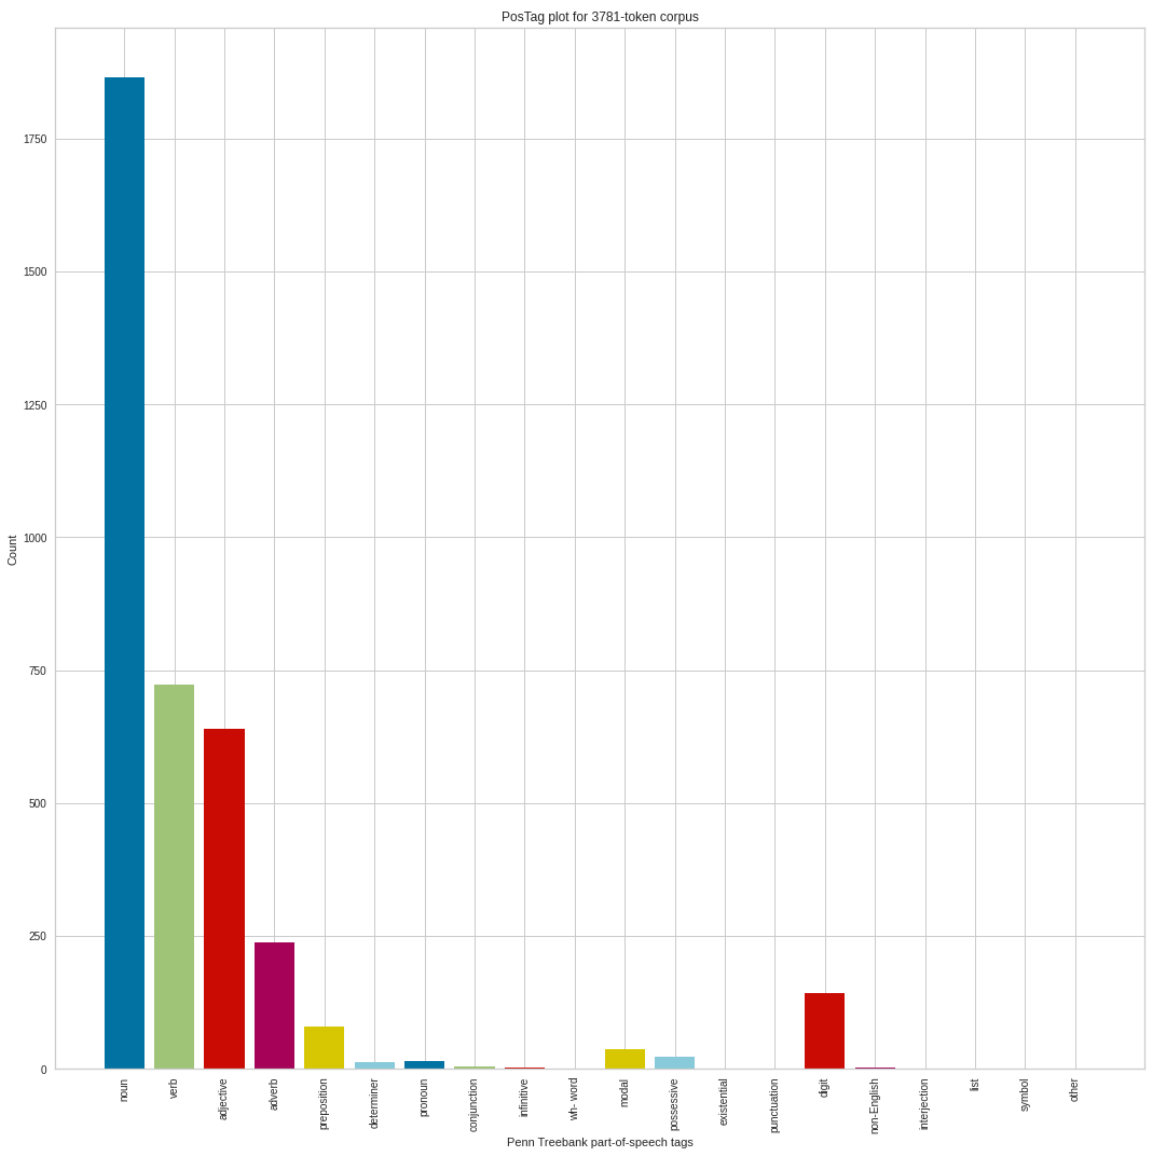
Figure 14. Part of speech tagging for positive tweets. The time period stands between 2 September 2021 and 4 Septem- ber